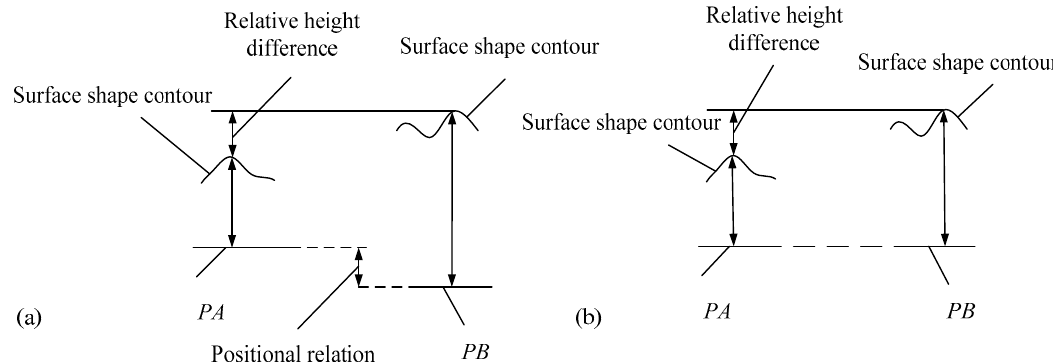
Figure 8. Geometric model of PA and PB cross section direction: ( a ) Positional relation exists between PA and PB surfaces. ( b )Positional relation does not exists between PA and PB